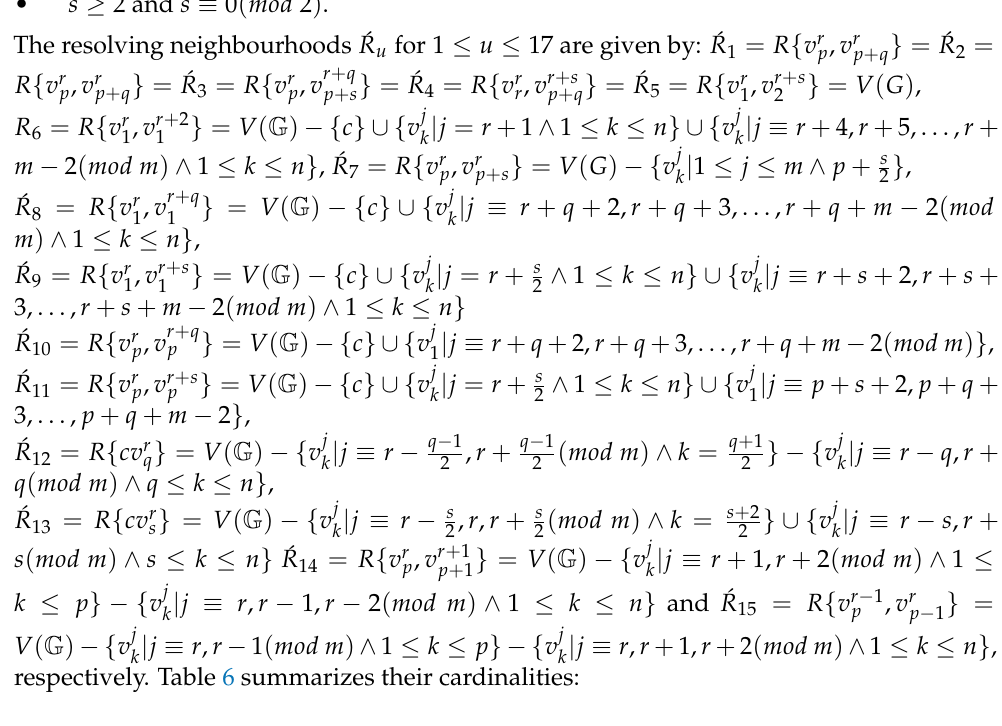
Table 6. Cardinalities of ´ R u for 1 ≤ u ≤ 15 and 1 ≤ j ≤